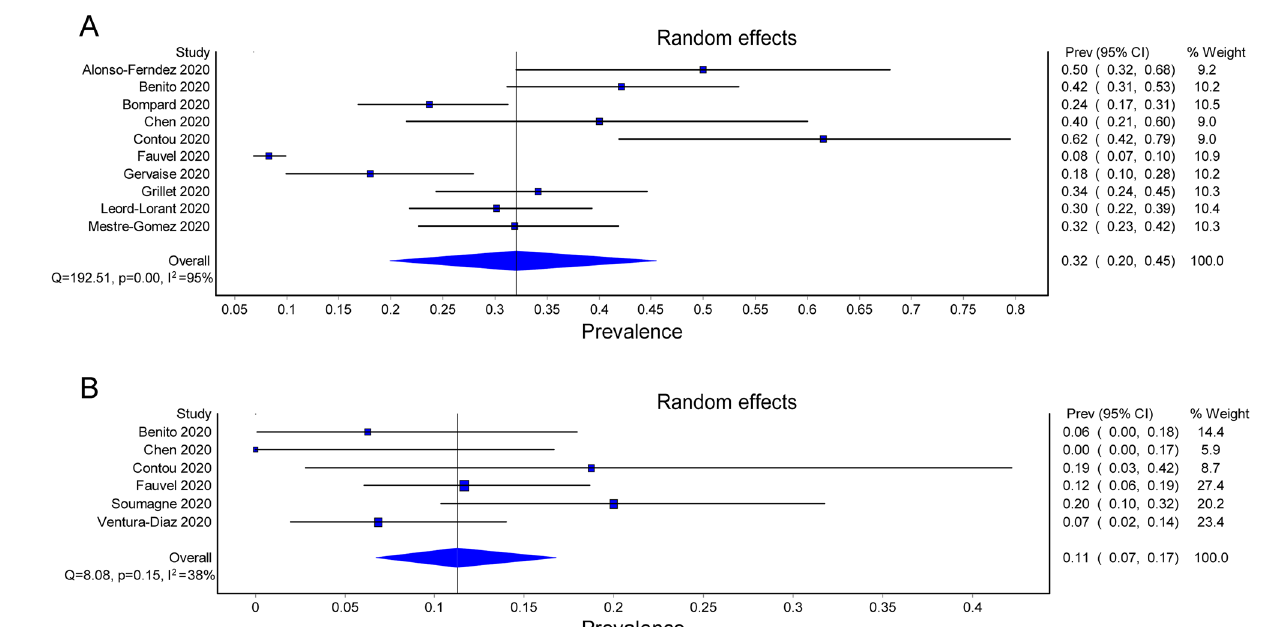
Figure 2. ( A ) The prevalence of pulmonary embolism in COVID-19 patients receiving computerized tomography pulmonary angiography (n = 10). ( B ) Reports on concurrent deep vein thrombosis (DVT) in COVID-19 patients with pulmonary embolism (n =